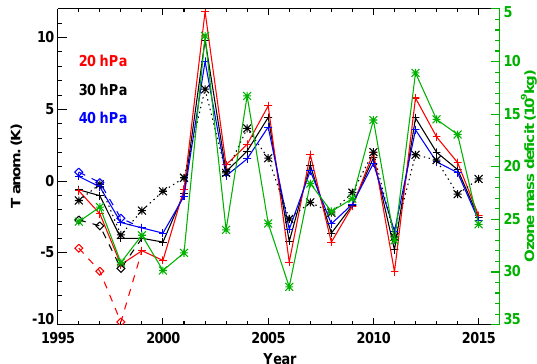
Figure 7. Annual average temperature anomalies for 28 August to 17 September within ± 2 ◦ latitude and ± 15 ◦ longitude of Scott Base. Results are shown at 20 (red), 30 (black), and 40hPa (blue). The dashed lines for 1996–1998 show the anomalies before apply- ing the bias correction to the MERRA temperatures (see text). Also shown (dotted black line) is the zonal temperature anomaly for this latitude range. The green line shows the ozone mass deficit, with values given on the right-hand axis (as in Fig. 5, but with the axis